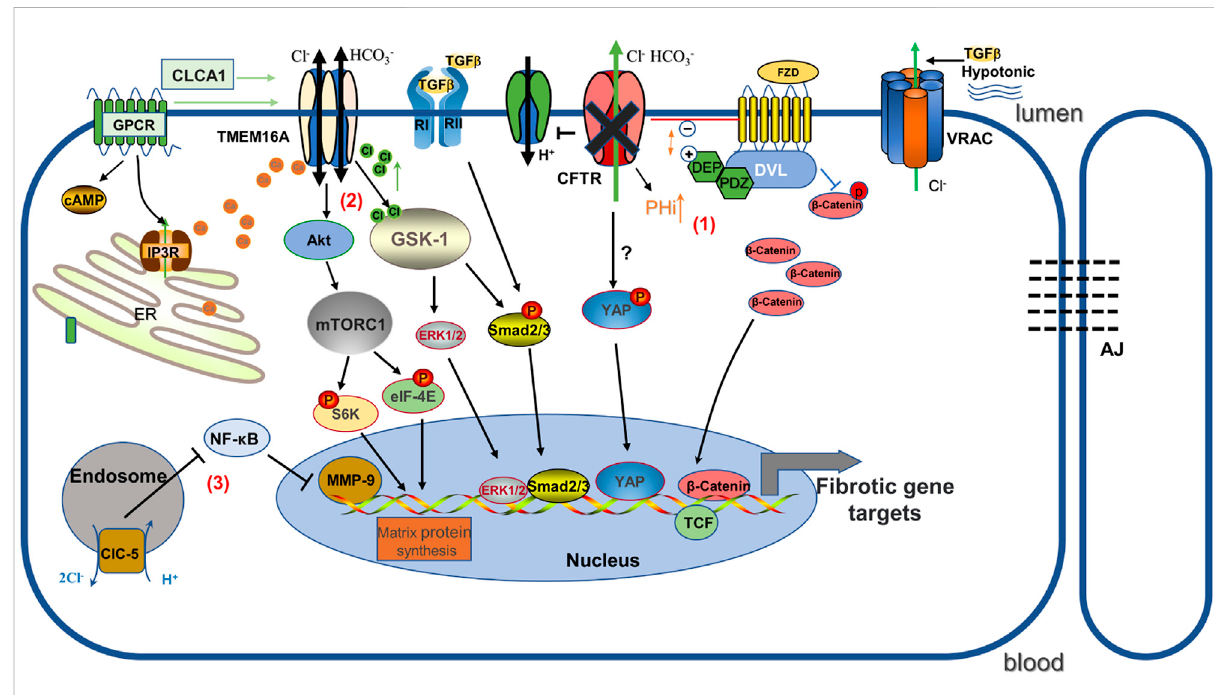
FIGURE 1 Schematic diagram illustrating the mechanisms by which several chloride channels affect gene expression in renal fi brosis. (1) CFTR de fi ciency causesincreasedintracellularpH.ItpromotesthebindingofpositivelychargedDEPandnegativelychargedphospholipidsattheplasmamembrane, and as aresult, increased association of FZDand Dvl inhibits thephosphorylated degradationof β -catenin and promotes Wnt/ β -catenin signaling. In addition, YAP may play a role in promoting renal fi brosis as one of the mechanisms. (2) TMEM16A stimulated by chloride channel accessory 1 (CLCA1) activates mTORC1-mediated matrix protein synthesis, and GSK-1 induces pro- fi brotic expression in response to TMEM16A-induced activation by increased Cl-concentration. (3)ClC-5 overexpression inhibits NF- κ B/MMP-9. FZD: Frizzled; DVL: Dishevelled; AJ: Adherens junctions; ClC-5: voltage-gated chloride